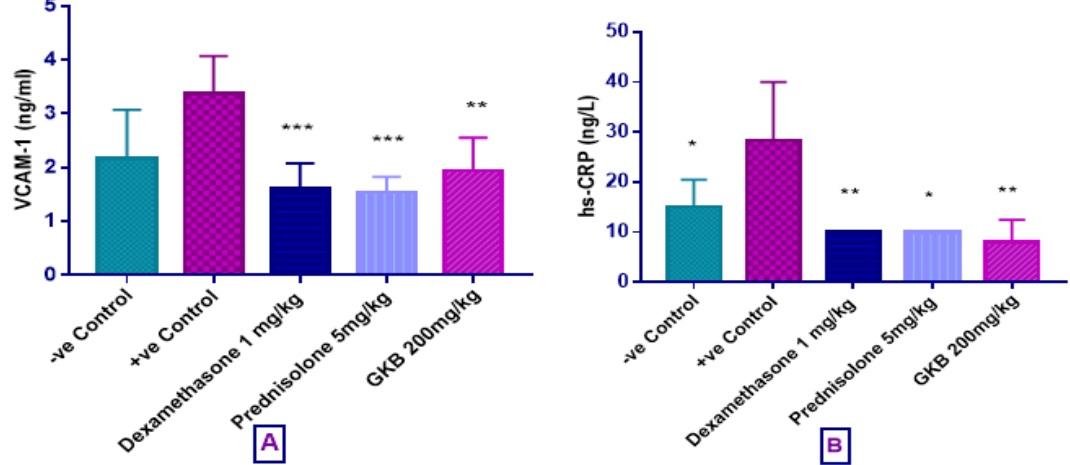
Figure 4.Effects of GKB extract on the inflammatory markers VCAM-1 (A) and hs-CRP (B) in granuloma model of inflammation. Values were presented as mean ± S.D (n= 6 animals in each group); values with (*) are significantly different from the positive control using ANOVA and post hoc test (* p < 0.05), (** p < 0.01), and (*** p <